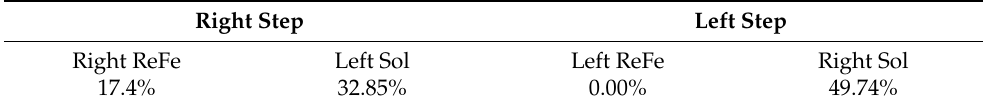
Table 3. Average onset detection percentage in the four control